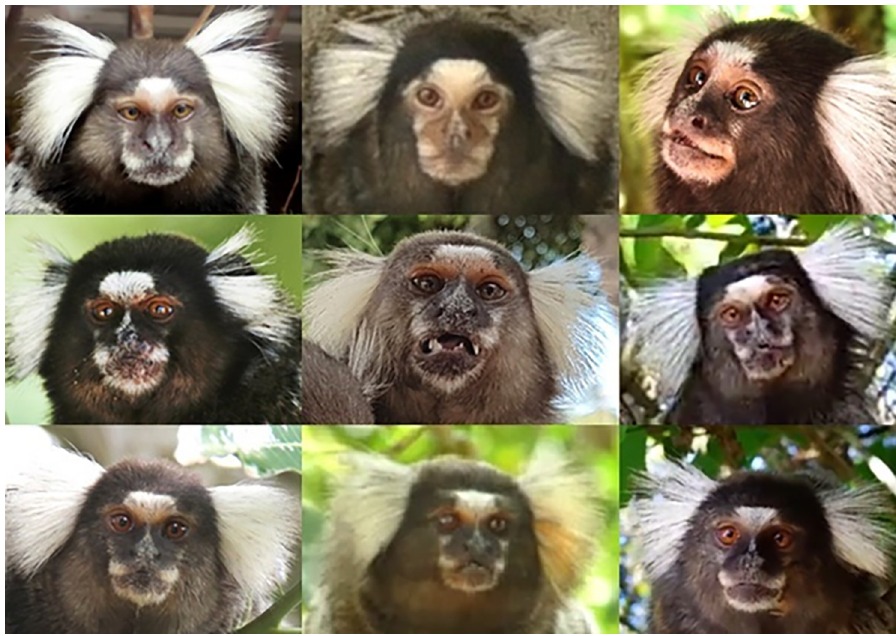
Fig 4. Variation of facial coloration in wild and captive marmosets.